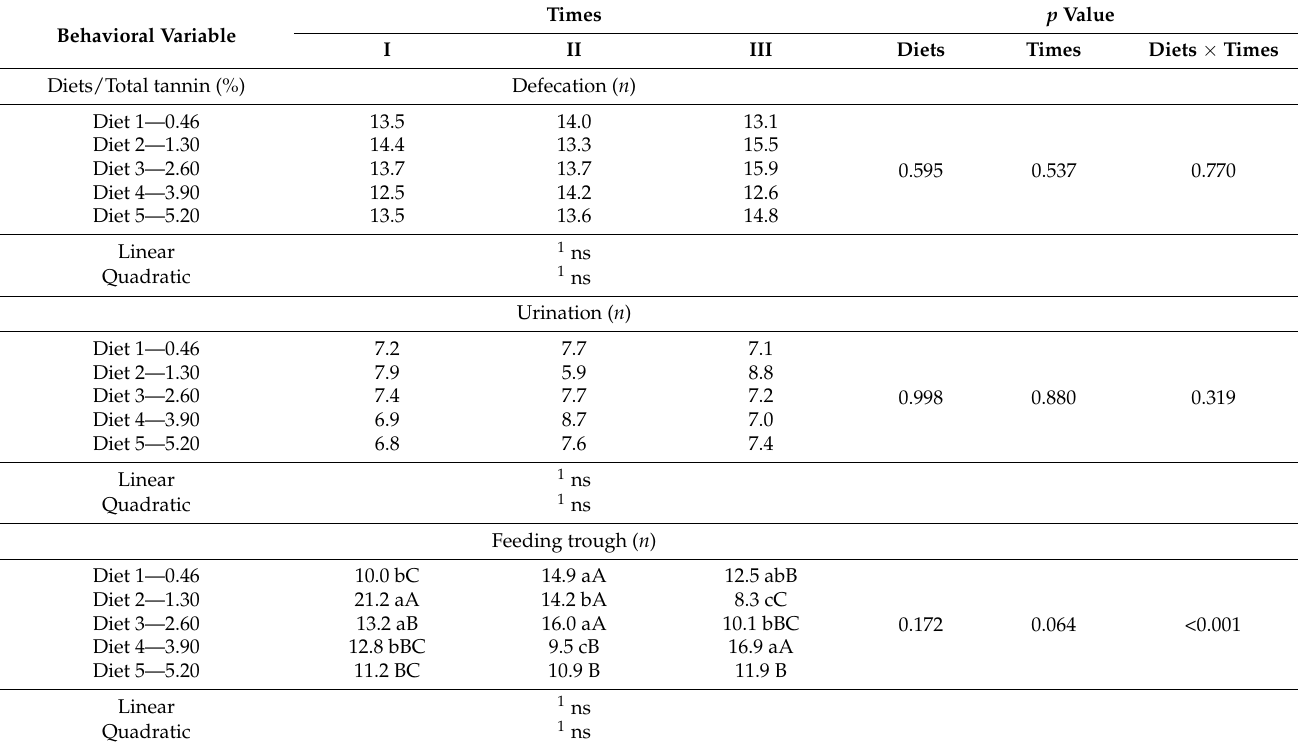
Table 2. Frequency of defecation, urination, and visits to the feeding trough and drinking trough by lactating dairy cows as a function of dietary tannin levels, in three times of the study